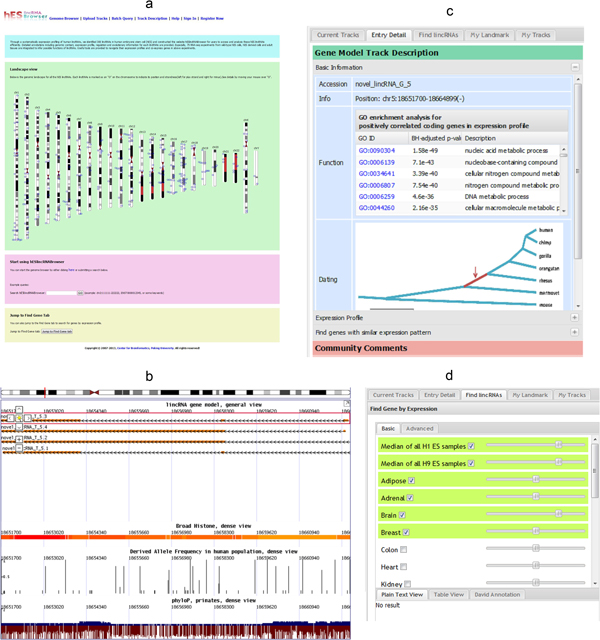
Web portal interface. (a) Welcome page; (b) main canvas for genome browse; (c) control panel to see detailed annotations; (d) find lincRNAs through user-specified expression pattern.